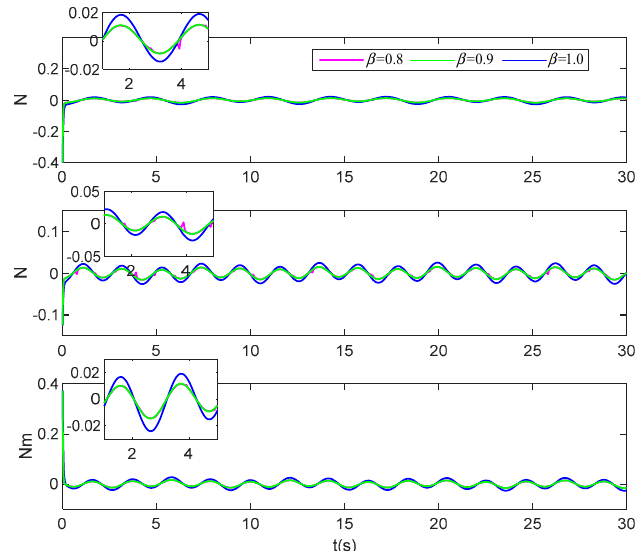
Figure 17. Disturbances and disturbances estimation under different orders.